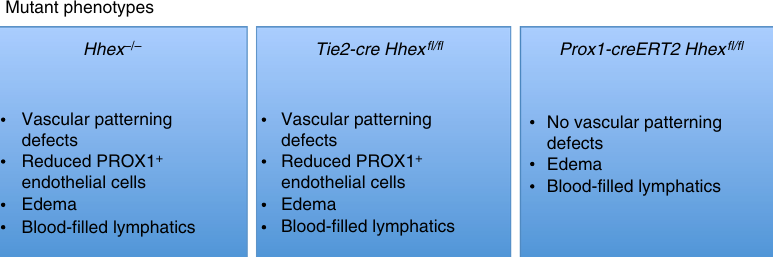
Fig. 9 Summary of the effects of global and conditional Hhex deletion during vascular development in mouse. a Stages when Hhex recombination occurs in Hhex − / − , Tie2-cre Hhex fl / fl , and Prox1-cre ERT2 Hhex fl / fl . b Consequences of Hhex deletion in Hhex -/- , Tie2-cre Hhex fl / fl , and Prox1-cre ERT2 Hhex fl /f are summarized in the blue boxes